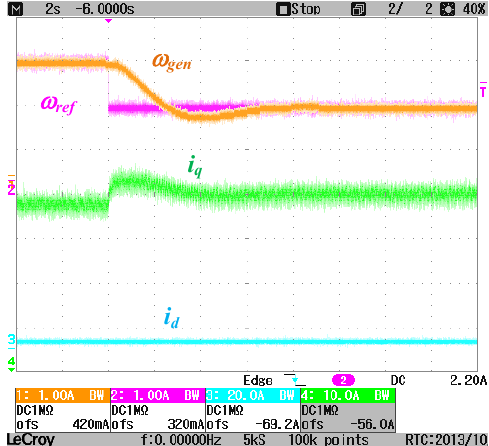
Fig. 19. Response for step change of speed with APFF. From top: estimated speed ( ω gen ), current in d-axis ( i d ), current in q-axis ( i q ), generator current ( i gen